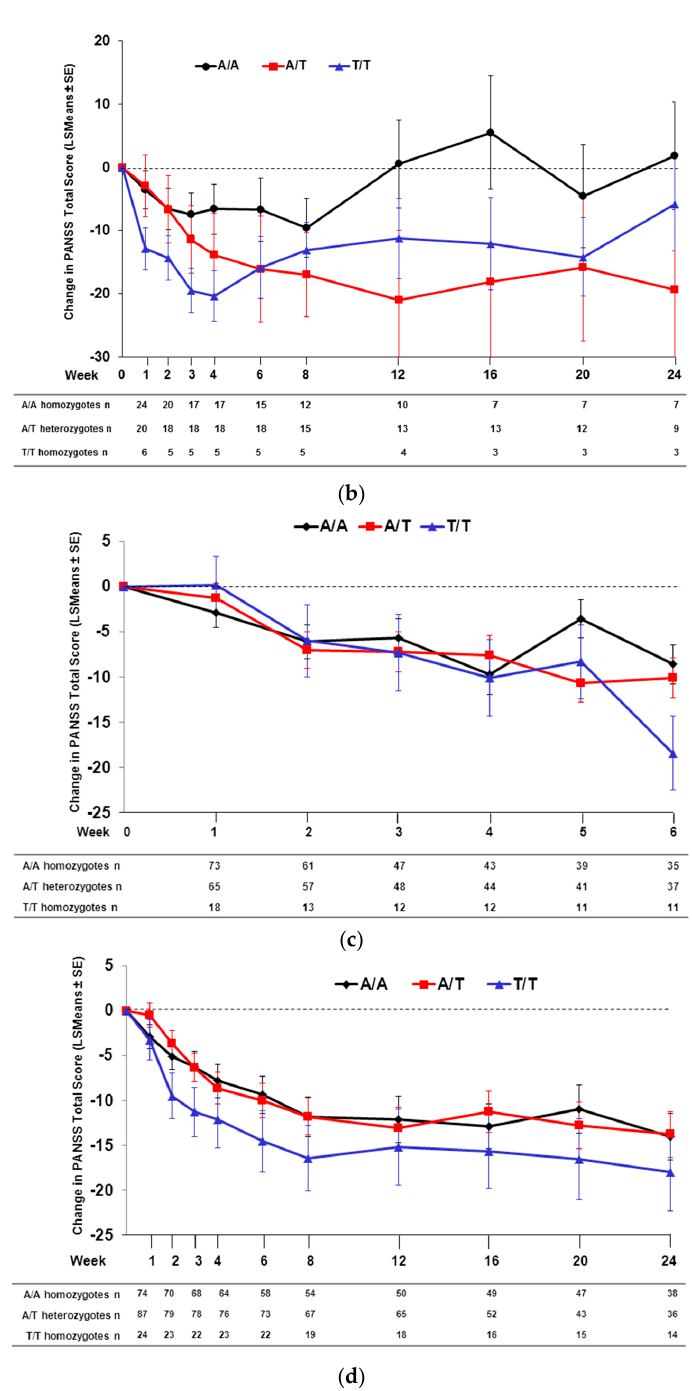
Figure 1. Change in PANSS total score in Caucasian patients treated with pomaglumetad methionil 40 mg BID by HTR2A SNP rs7330461 genotype. ( a ) Study 1. ( b ) Study 2. ( c ) Study 3. ( d ) Study 4. Abbreviations: BID = twice daily; HTR2A = serotonin 2A receptor ( HTR2A ) gene; n = number of patients with PANSS measures; LSMeans = least squares means; PANSS = Positive and Negative Syndrome Scale; SE = standard error; SNP = single nucleotide polymorphism.